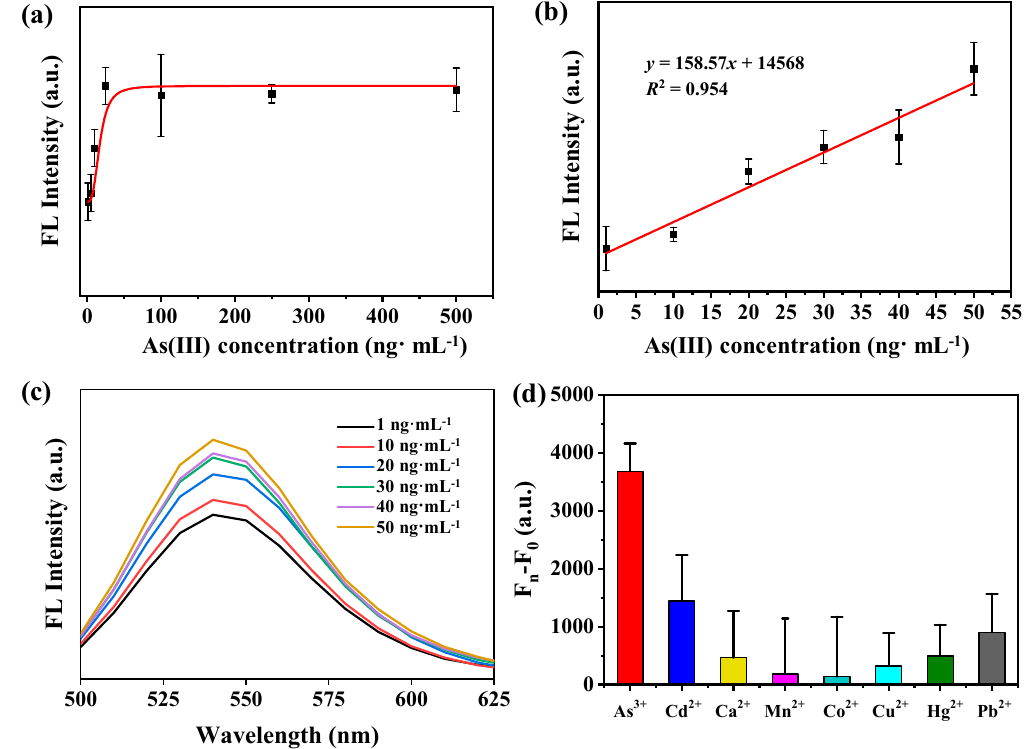
Figure 6. ( a ) The luminescence recovery curve of the probe in the As(III) concentration range of 1–500 ng · mL − 1 . The luminescence recovery curve ( b ) and luminescence spectra ( c ) of the nanoprobe in the presence of As(III) range from 1 to 50 ng · mL − 1 ; ( d ) Response of nanoprobe to di ff erent interfering ions, the concentration of As(III) was 10 ng · mL − 1 , F 0 represents the luminescence intensity before the addition of ion while F n was the luminescence after incubated with ions. Table 1. Related reports on nanomaterial-based sensors for the detection of As(III).